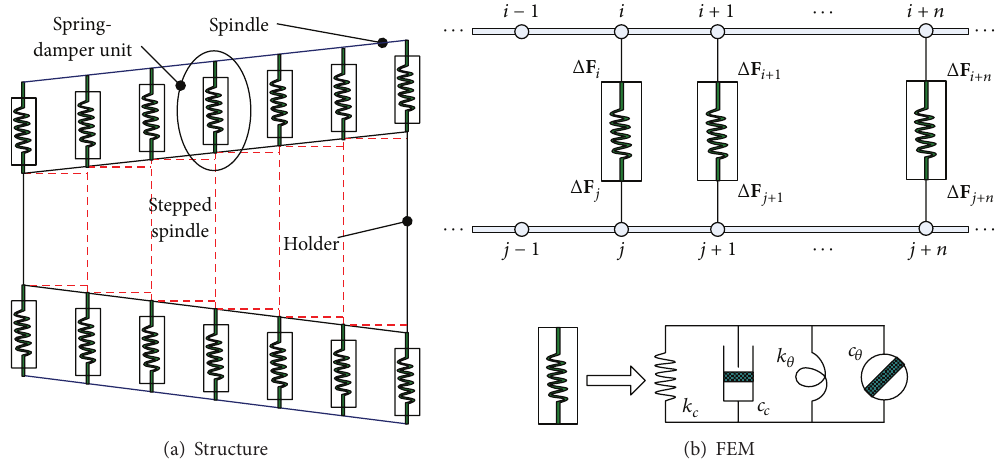
Figure 6: The distribution spring model of spindle-holder joint.